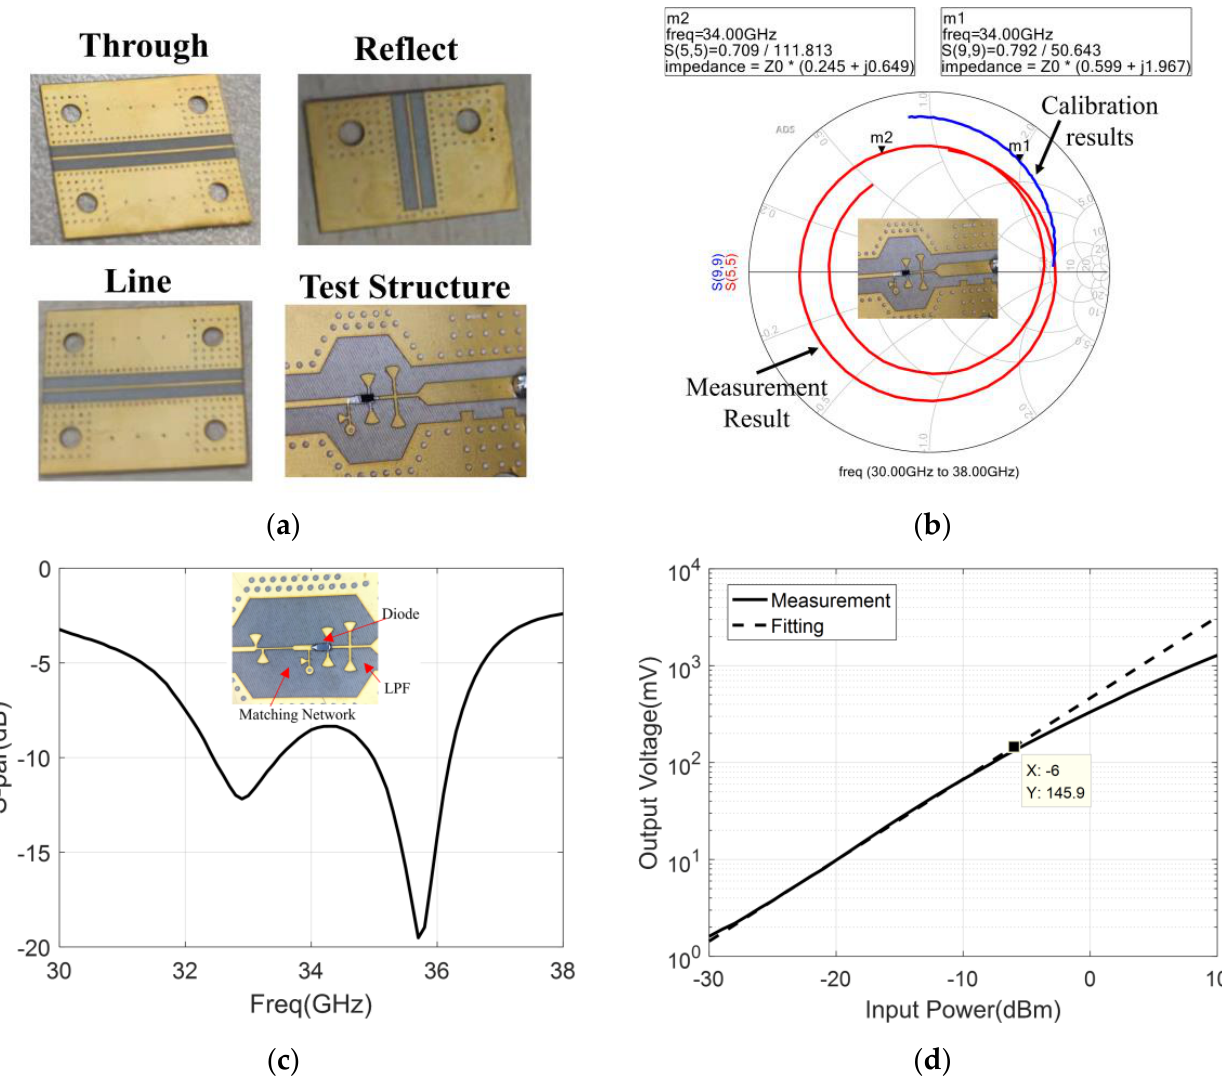
Figure 9. The calibration, design, and measurement of the detector: ( a ) the TRL calibration model and test structure; ( b ) the measurement and calibration results of the test structure; ( c ) the final fabricated detector and its return loss; ( d ) the output voltage of the detector versus input power.